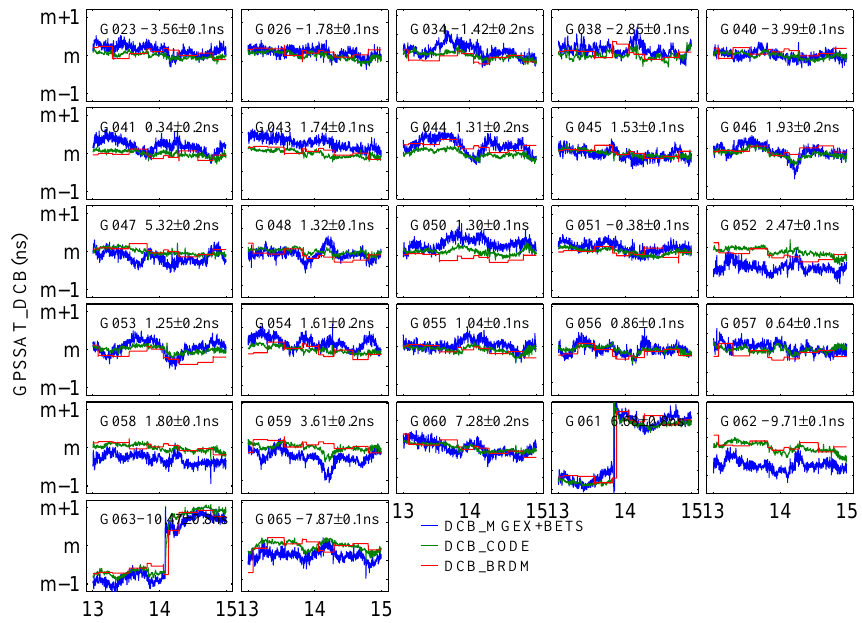
Figure 5. DCB (C1W–C2W) variations in GPS satellites derived from BETS and MGEX data based on GIMs. The blue, cyan, and red lines are the results from BETS and MGEX BDS data, broadcast navigation messages, and CODE,